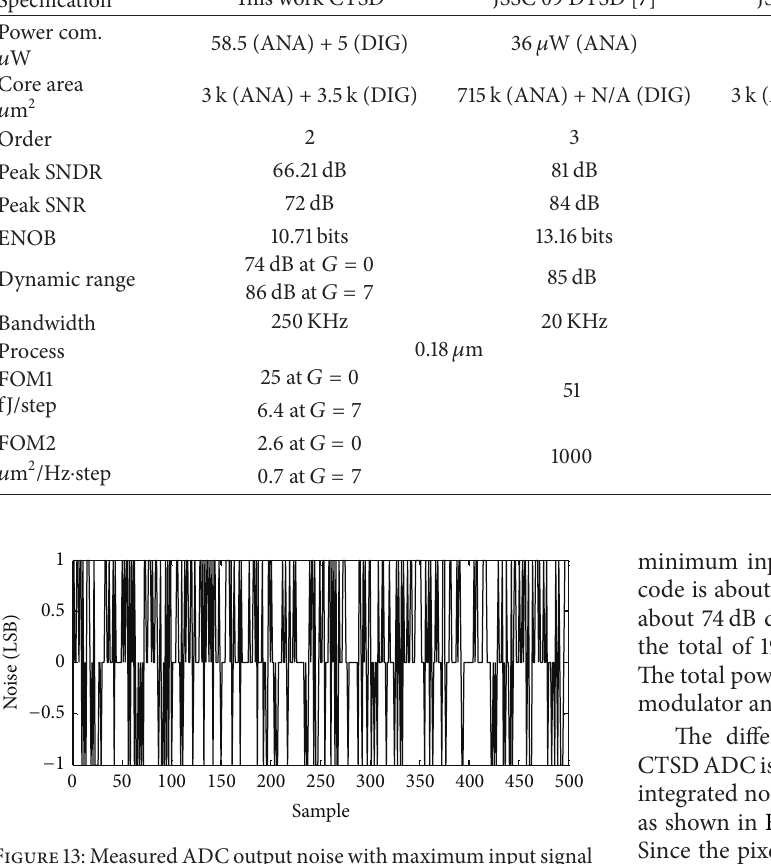
Figure 13: Measured ADC output noise with maximum input signal (500 sample points), indicating 0.7-LSB RMS noise and 72 dB peak SNR.